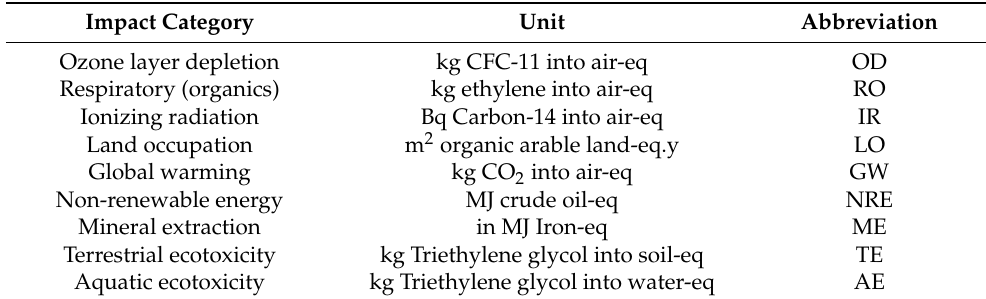
Table 2. Selected impact categories investigated in this study. Impact